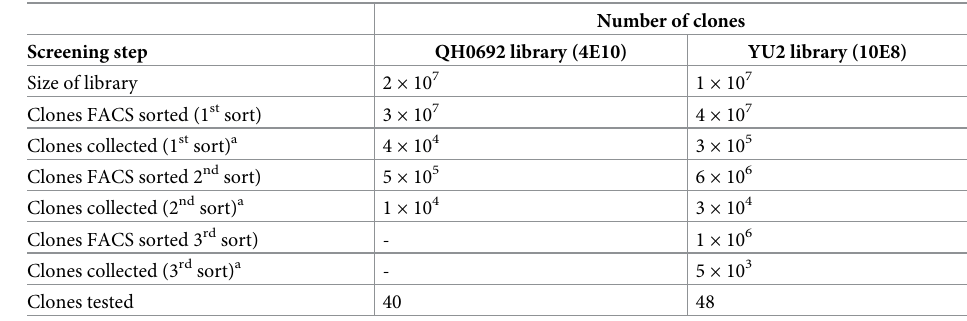
Table 1. Mutagenic screens for UCA-binding Env variants.